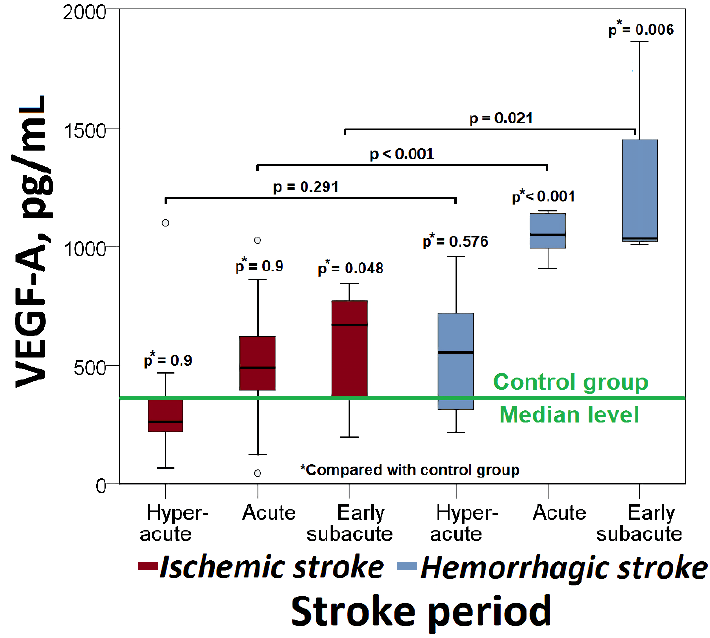
Figure 1. Changes in serum VEGF-A level in patients with ischemic or hemorrhagic stroke.